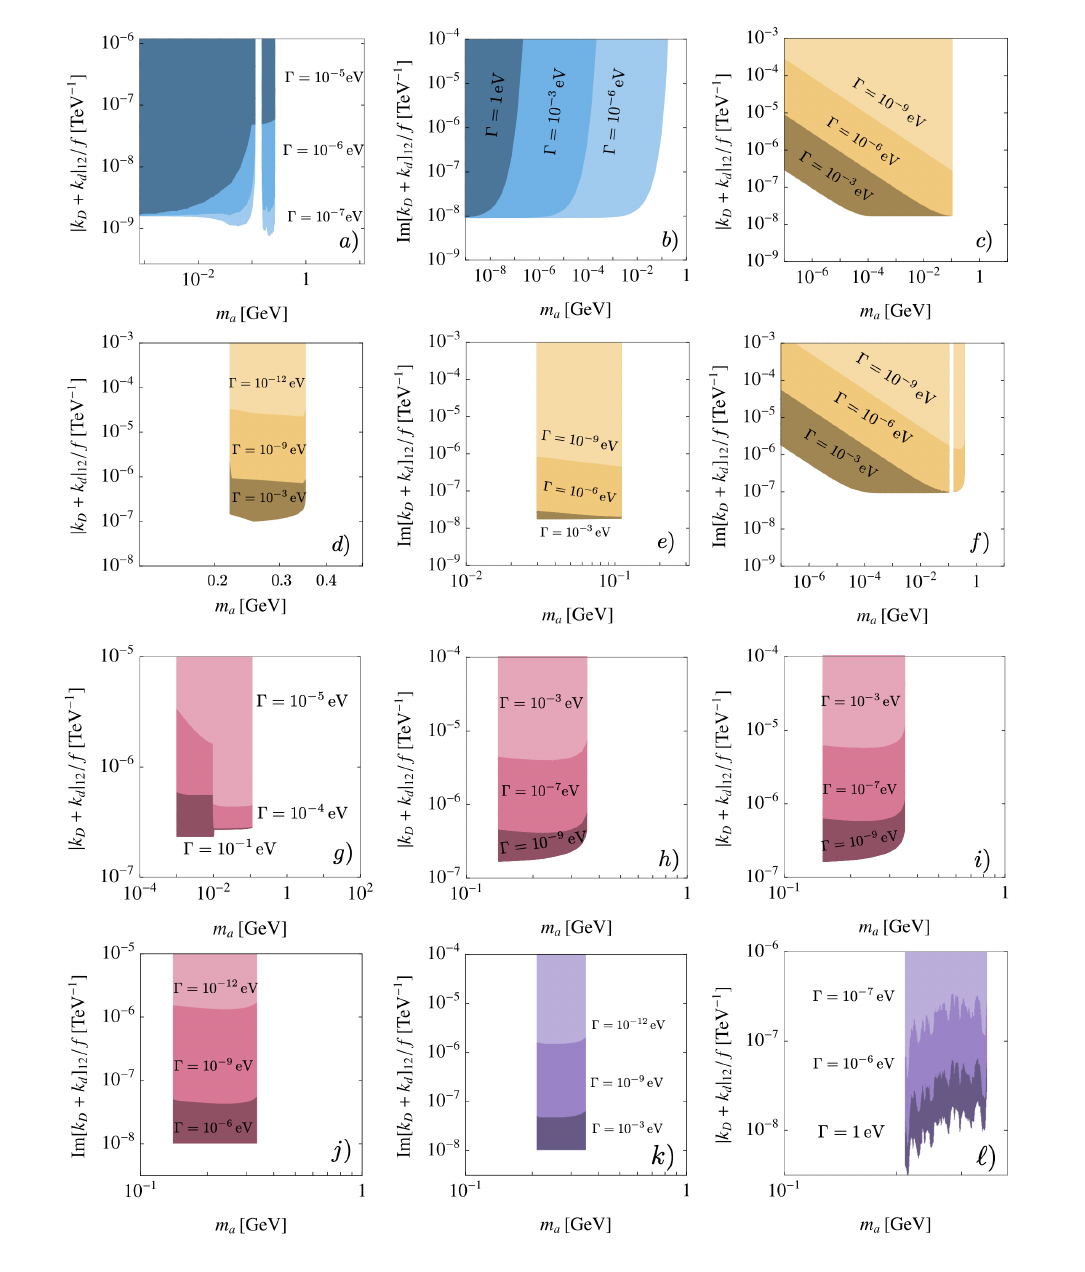
Figure 7 . Constraints on the flavor-violating ALP couplings [ k d ] 12 and [ k D ] 12 from kaon decays, collected in table 1, for different values of the total ALP width. The color-coding indicates the final state: red is for a → e + e − decays and purple for a → µ + µ − decays. The different contours in panel a) and g) are the result of the experiments providing different constraints depending on the ALP